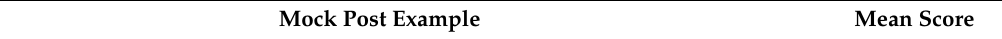
Table 3. Number of participants rating Mock Facebook post as the most motivating to increase calcium-rich foods and the mean score (1 is the highest motivation and 5 is the lowest motivation possible).